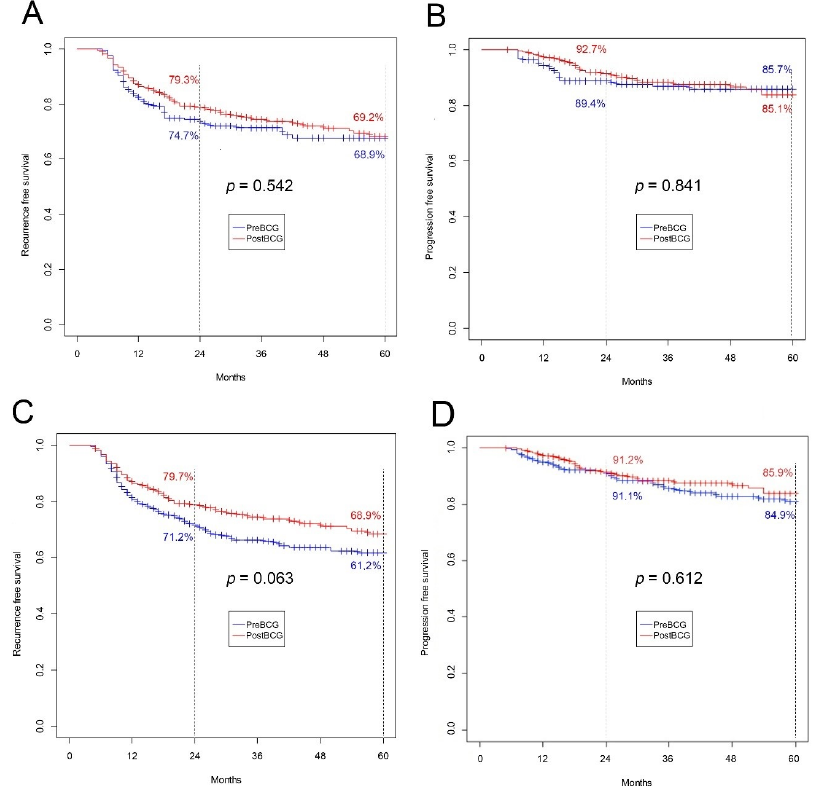
Figure 4. ( A ) Recurrence-free survival for five-year follow-up after PSM ( p = 0.542); ( B ) progression- free survival for five-year follow-up after PSM ( p = 0.841); ( C ) recurrence-free survival for five-year follow-up after IPW ( p = 0.063); ( D ) progression-free survival for five-year follow-up after IPW ( p = 0.612). ). IPW, inverse-probability weighting; PSM,